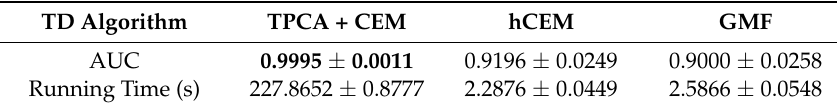
Table 5. AUCs and running times for TD on synthetic datasets with different TD algorithms repeated 20 times.